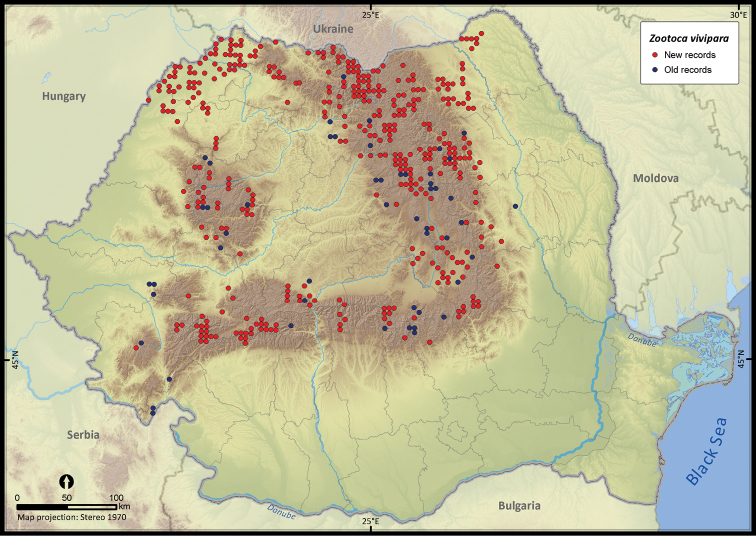
Zootoca vivipara.